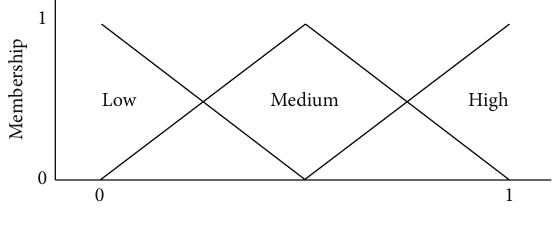
Figure 4: Example of fuzzy expression levels.